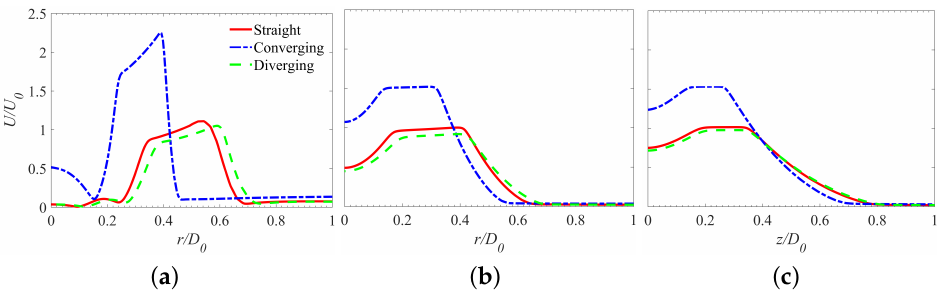
Figure 15. Velocity magnitude in the r − θ plane z = H at ( a ) H = 0.5, ( b ) H = 2, and ( c ) H = 4. 2 The distance between the jet mainstream and the axis and the width of the jet is also affected by the nozzle shape. The jet flow moves radially inward under the restriction of the outer wall of the converging nozzle. As a result, the jet mainstream is closer to the central axis, and the width of the jet is much narrower than the width in the datum case, whereas the flow with the diverging nozzle moves radially outward with a slightly wider jet. In Figure 16, high TKE values are found in the inner and outer shear layers where more fluctuations and turbulent mixing happen. In converging cases, the contraction of the nozzle contributes to higher turbulent intensity in the outer shear layer and the flow of higher velocity also generates strong fluctuations. As a result, the TKE value in the converging nozzle is much higher than the value in the straight nozzle, and the high TKE can further boost the heat transfer on the impingement surface. The difference